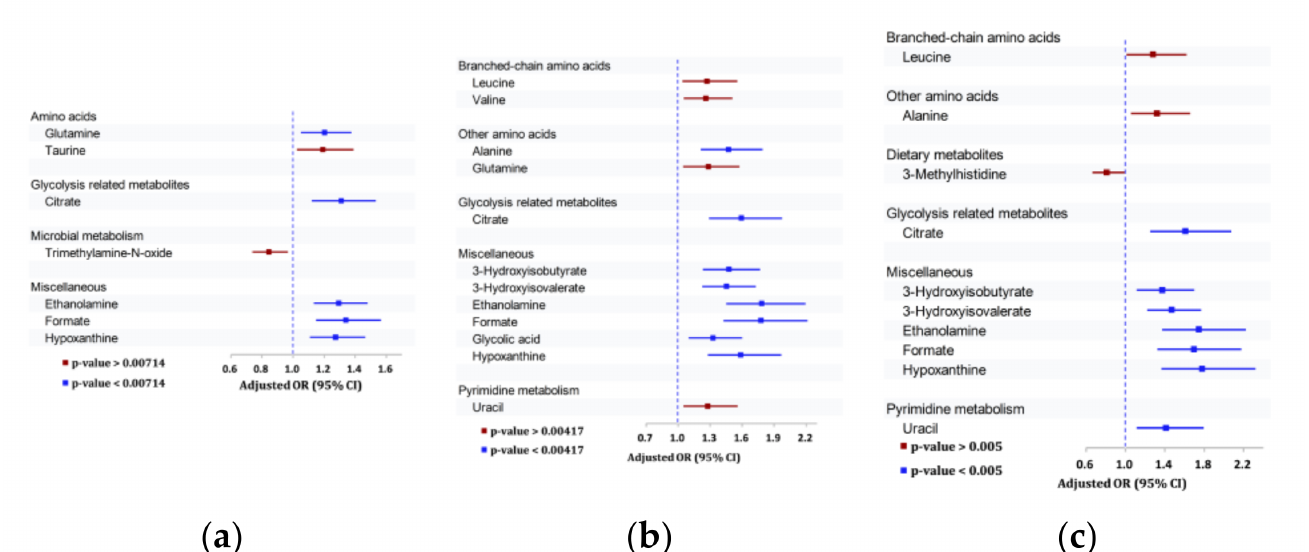
Figure 2. Association between urinary metabolites and ( a ) any DR, ( b ) moderate/above DR, and ( c ) vision-threatening DR in Chinese and Indians cohorts. OR estimate corresponds to per SD ↓ in urine metabolites; OR estimates adjusted for age, sex, systolic BP, duration of diabetes, and